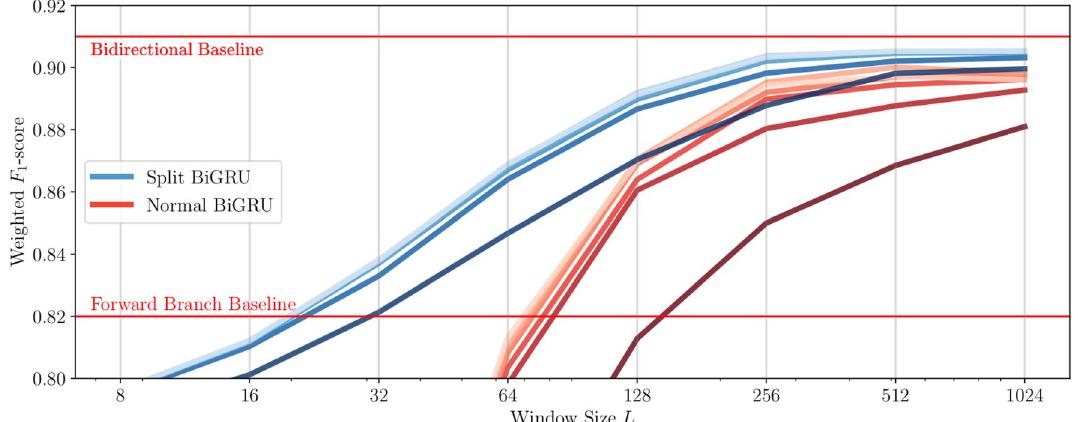
Figure 6. Weighted F 1 -score comparison versus hop sizes. The gradients correspond to hop sizes , L , L , L , L , L } , with darker colours corresponding to a larger hop size H . A lower and upper bound are ∈ { L 1 2 3 4 5 6 marked in red. These lower and upper bounds correspond to the accuracy achieved using only the forward network, and the full (forward and backward) network on an entire recording. The weighted F 1 -scores lower than the baseline forward GRU are not shown, as these constitute configurations that are worse than using a regular recurrent neural network.